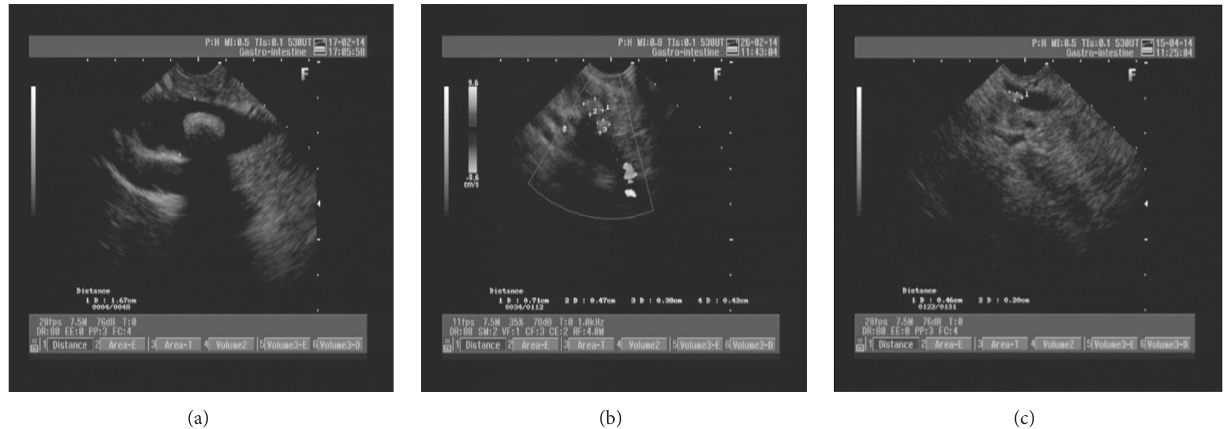
Figure 1: The diameter of common bile duct stones measured on linear endoscopic ultrasound. (a) > 1cm, (b) 0.5–1.0 cm, and (c) < 0.5cm.